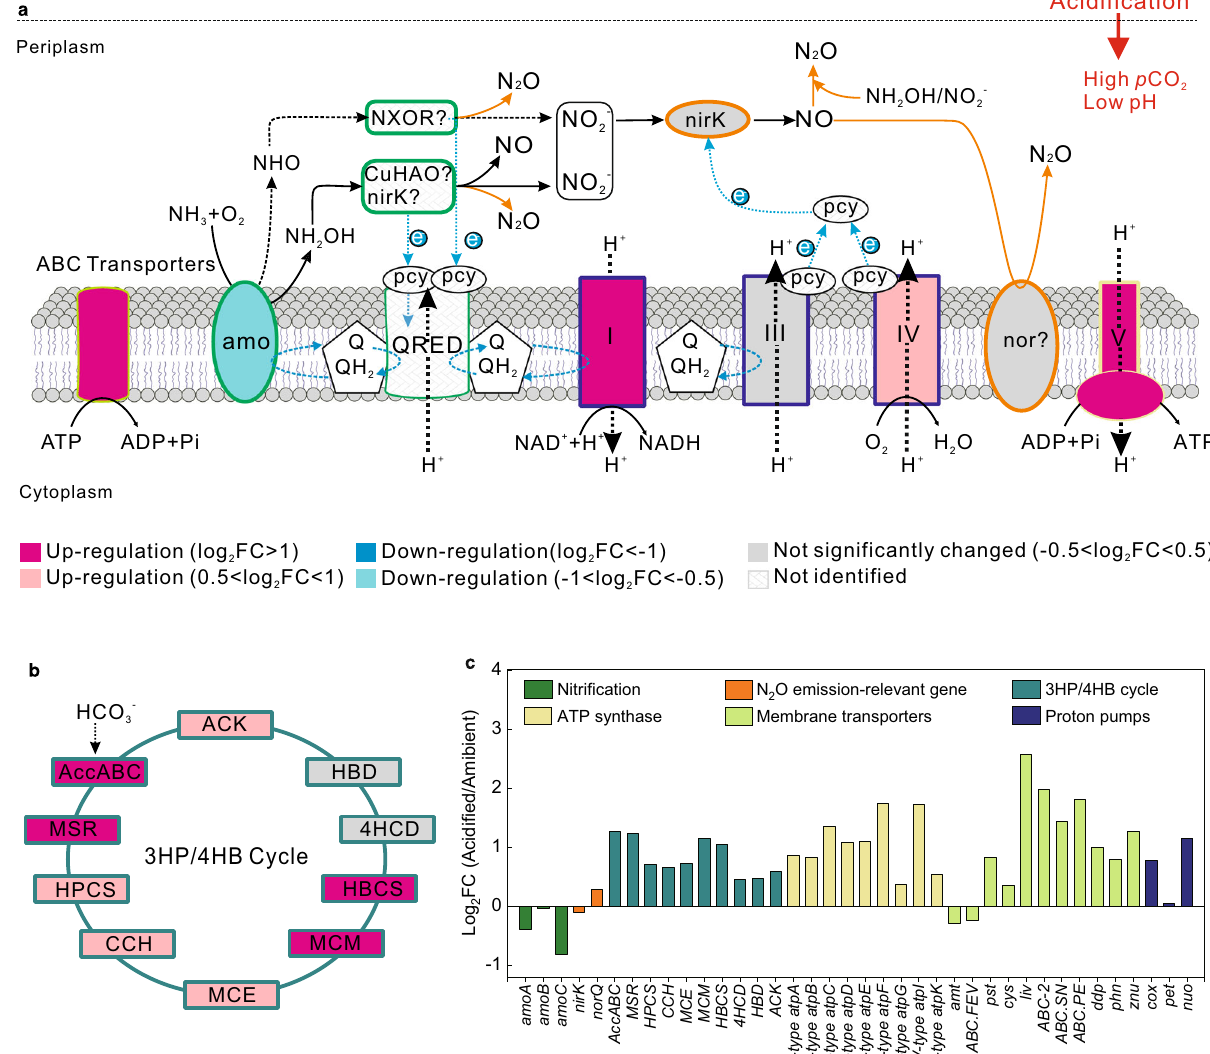
Fig. 5 | Response of ammonia-oxidizing archaea (AOA) to acidi fi cation. a Schematicmodeldepictingtheeffectsofacidi fi cationontheexpressionofgenes involved in NH 3 oxidation, N 2 O production, energy generation, and cytosolic pH homeostasisofAOA.Foldchange(FC)inrelativegeneexpressionwascalculatedby comparing the acidi fi edsamples totheambientcontrol. Theromannumbersrefer to the enzyme complex I (NADH dehydrogenase), complex III ( b -pcy), complex IV (pcy-aa 3 ), and complex V (ATP synthase) in the respiratory chain. Dotted blue